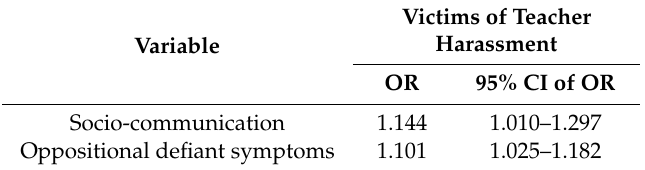
Table 2. Factors related to the victims of teacher harassment: forward logistic regression